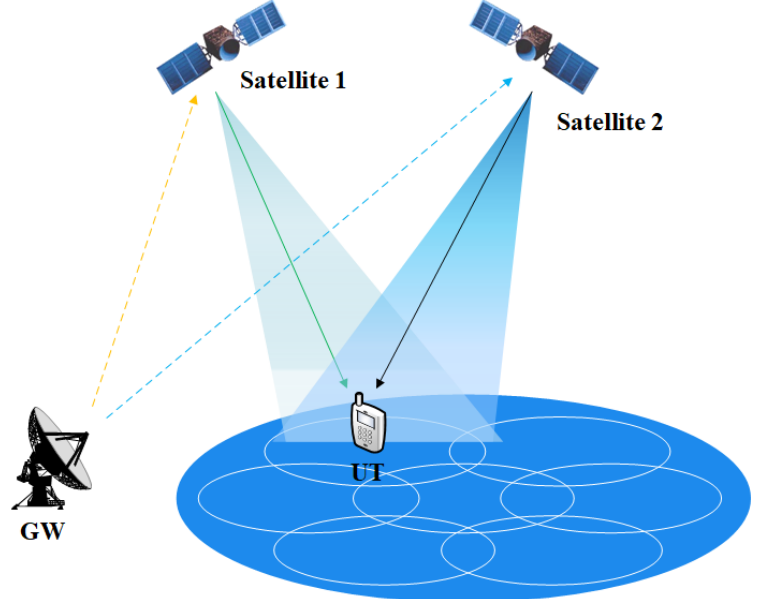
Figure 1. The dual-stream transmission for LEO satellites-assisted IoT